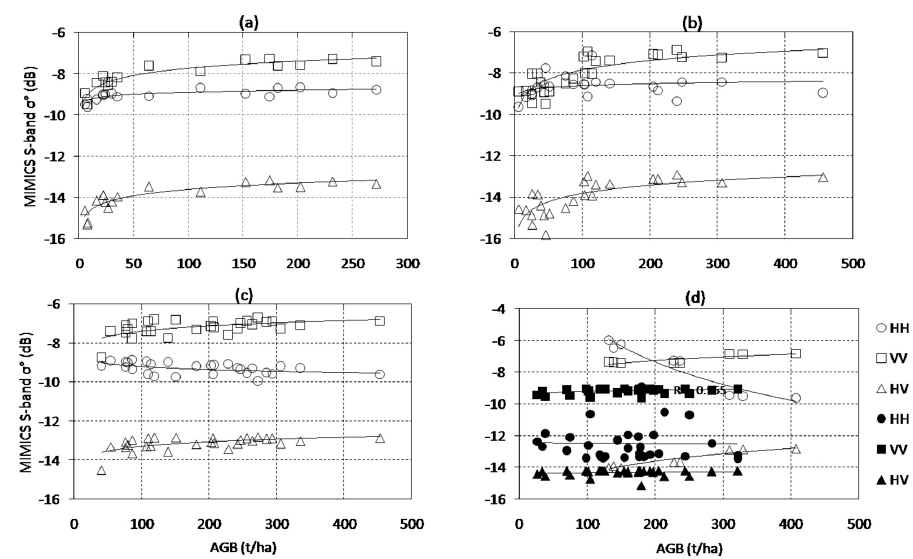
Figure 4. Simulated backscatter for S-band against forest AGB as a function of varying forest biomass for Tapajós ( a ); Cameroon ( b ); Dudhwa National Park ( c ); and Kashmir ( d ) for broadleaved (no fill) and needleleaved (filled) stands at different polarisations at 30° incidence angle. Best fit log relationships were fitted for ( a – d ). Table 6. Results from the regression models relating MIMICS-I simulated S-band backscatter ( σ °) to plot biomass for broadleaved stands. r 2 is the coefficient of determination and RMSE is the root mean square error (t/ha) calculated using plots. Site r 2 Slope Confidence Interval Site Polarisation r 2 RMSE (t/ha) Lower